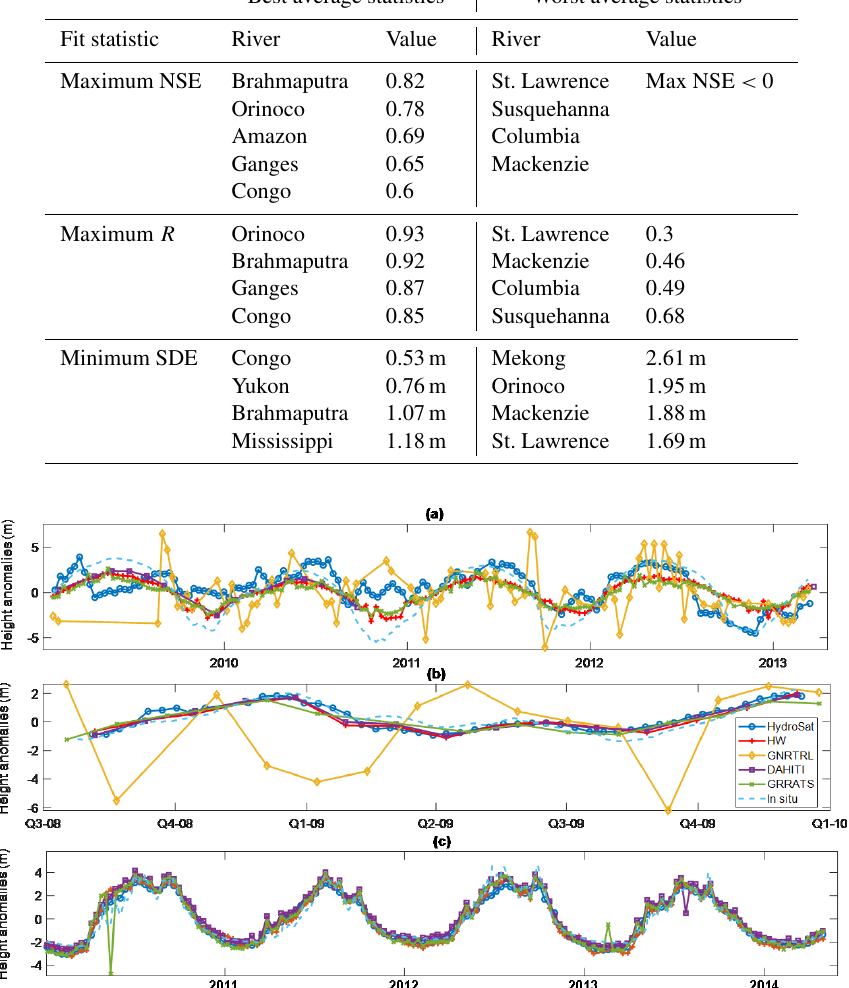
Figure 4. Multiproduct evaluation at the same location. Panel (a) : multiproduct comparison on the Amazon River. Panel (b) : multiproduct comparison on the Congo River. Panel (c) : multiproduct comparison on the Brahmaputra river. DAHITI is plotted in purple with square markers, HydroSat in dark blue with circle markers, River&LakeNRT (GNRTRL) in yellow with diamond markers, Hydroweb in red with cross markers, and GRRATS in green with x markers and in situ in dashed light blue. Note that the legend in panel (b) applies to all of Fig. 4. GRRATS error bars not shown to improve